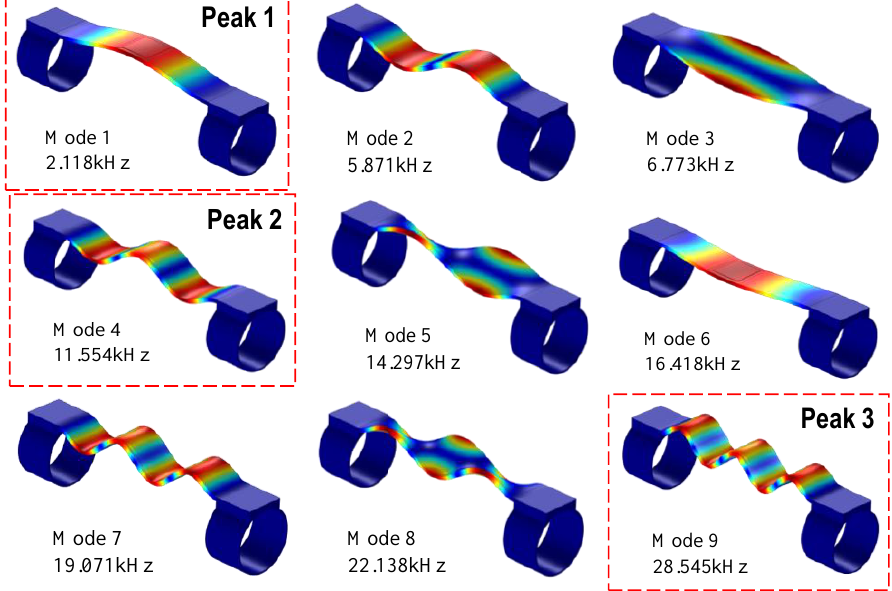
Figure 6. Nine modal shapes of wearable PZT interface.